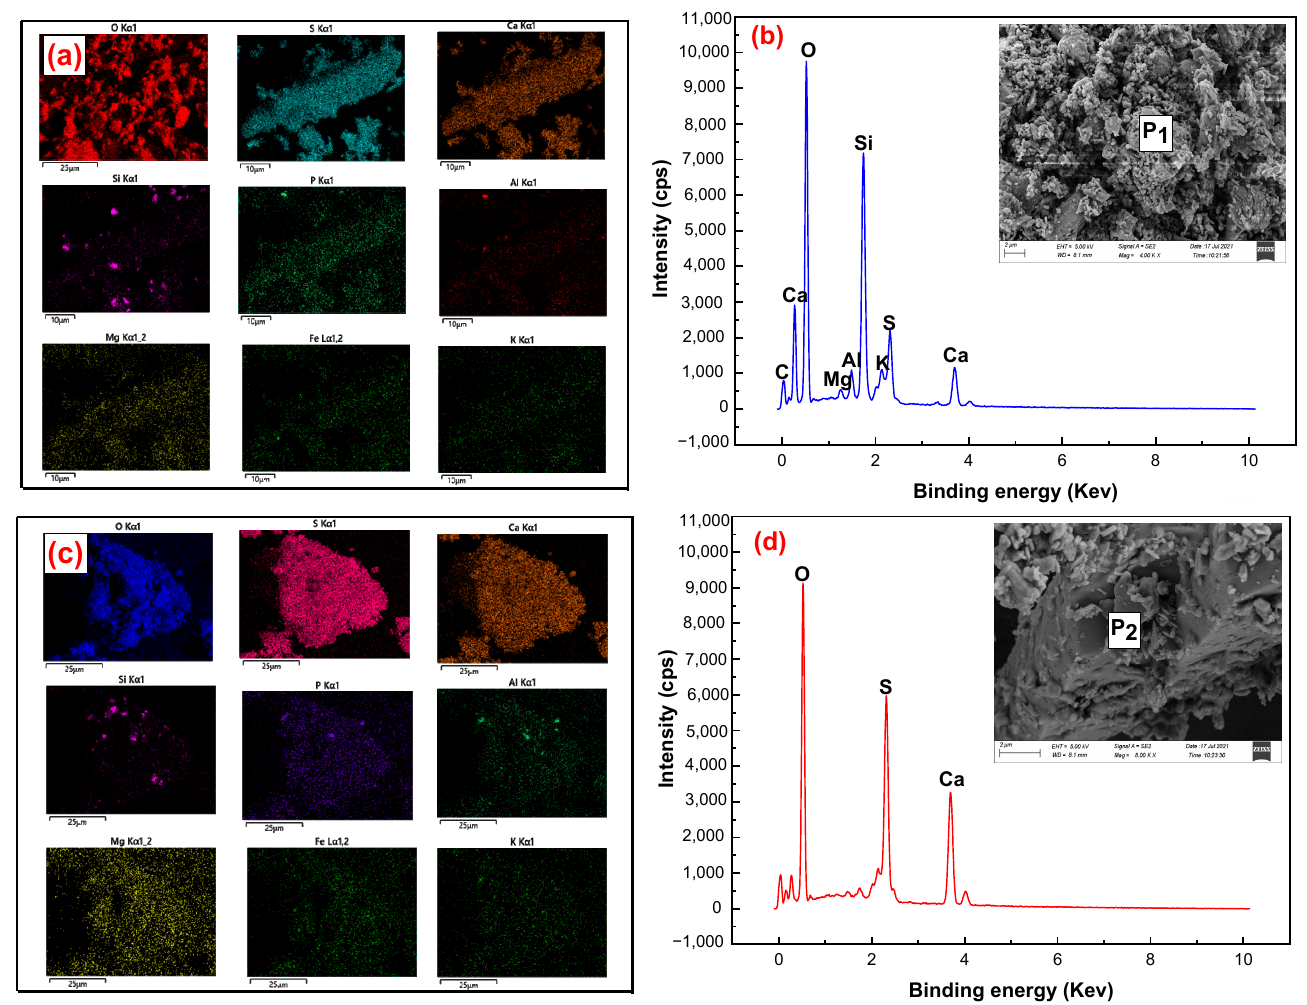
Figure 11. SEM-EDS analysis of ( a , b ) phosphogypsum, and ( c , d ) gypsum concentrates.